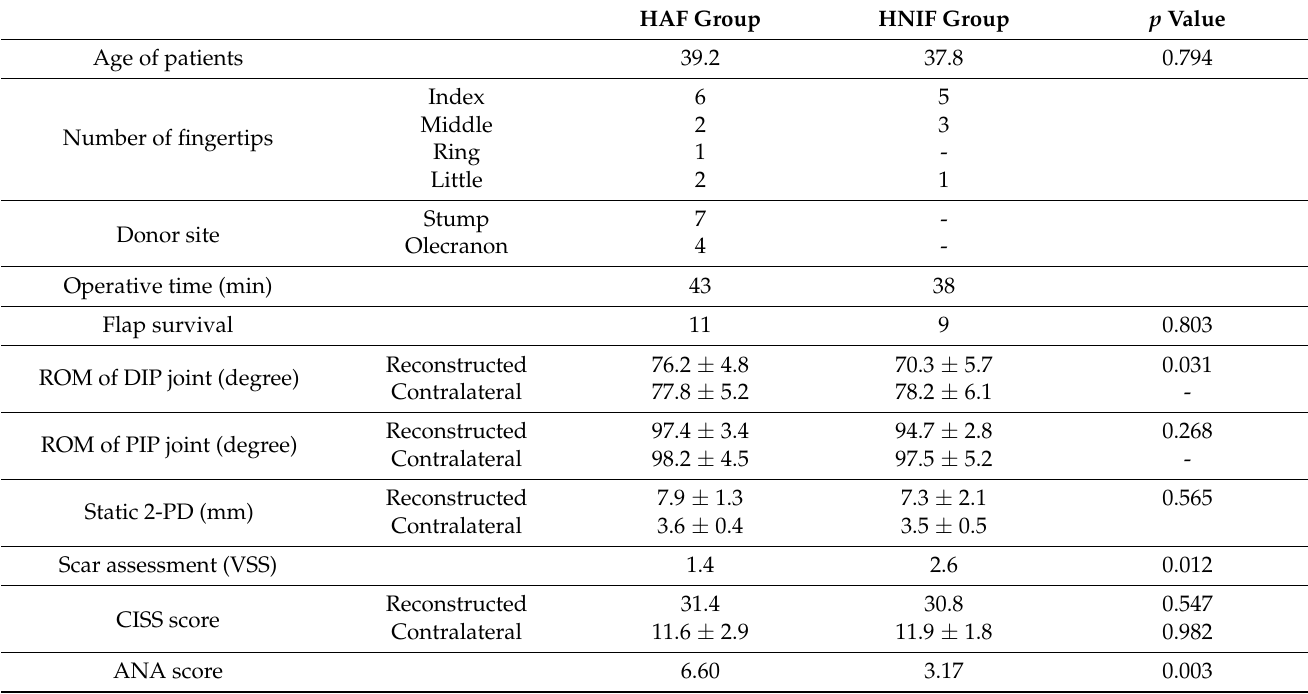
Table 1. Comparison of the results of both surgical methods. HAF Group HNIF Group p Value